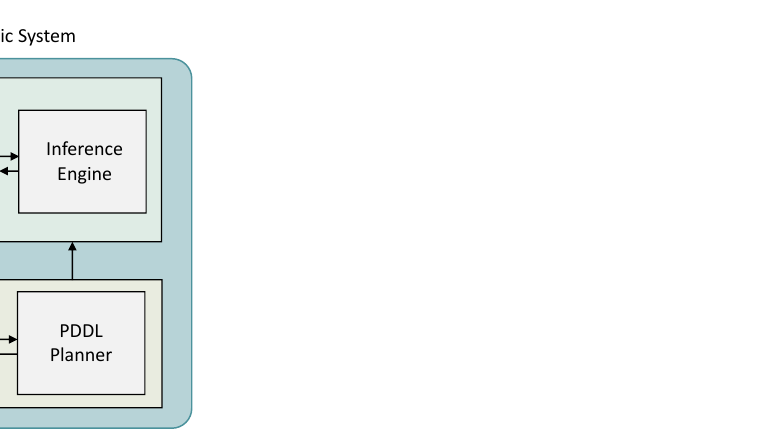
Figure 2. PDDL-based symbolic system, consisting of two parts: the first part is the knowledge base and interface engine, in which the domain information of task planning expressed with symbolic representation is saved; the second part is the PDDL-based domain and problem description and the PDDL planner for executing tasks by planning the sequence of actions.